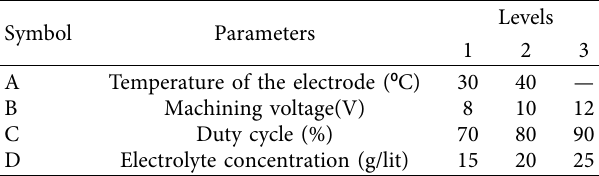
Table 3: Parameters of machining and their levels.